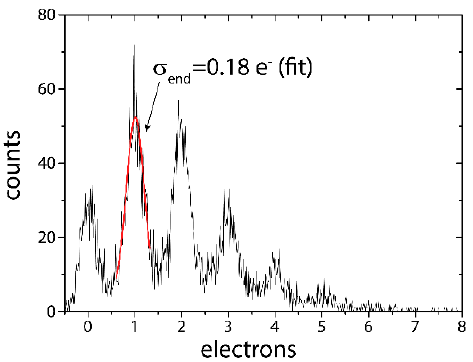
Figure 9. Single photon spectrum measured at low light intensity with a circular RNDR-DEPFET at a temperature of − 55 °C. Due to the higher amplification the read noise of a single readout is only 3.1 e − rms and a minimum noise of 0.18 e − was obtained with only 300 readouts.